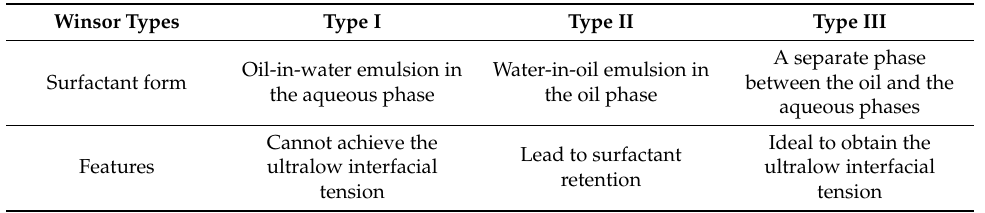
Table 1. Summary of microemulsion types (Winsor